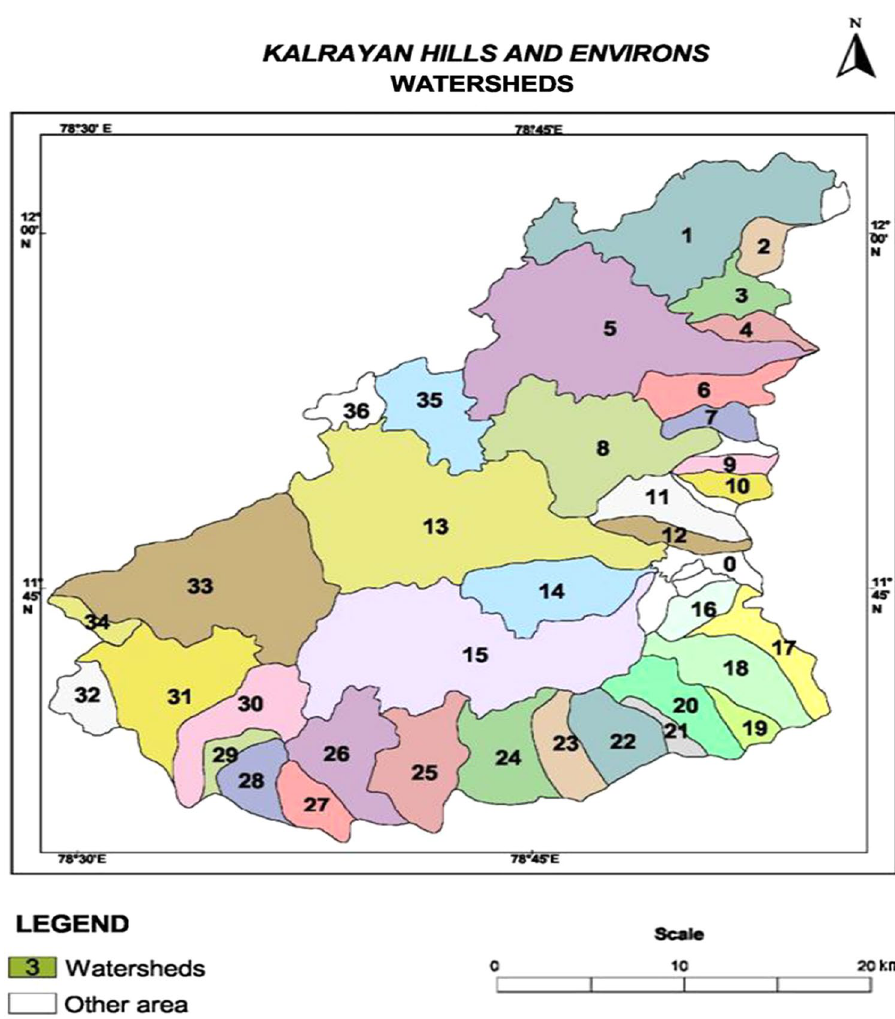
Fig. 2 Watershed map of the study